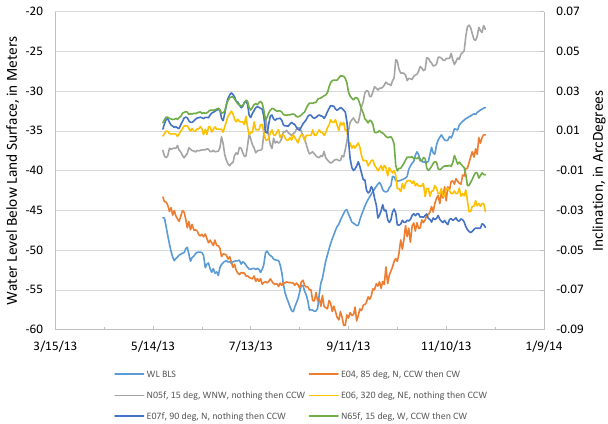
Figure 4. Biaxial tilt compared with water-level fluctuation in ob- servation well 0.8km to the south. Sensor locations are in Fig. 1. The legend gives the azimuth of the vertical plane of tilt, viewing di- rection, and sense of rotation for two segments of each graph. CW is clockwise; CCW is counterclockwise. Response to water-level fluc- tuation is delayed about one month and sensors on opposite sides of the fissure zone respond with the opposite sense. Only E04 and E07f exhibited tilt in the vertical plane orthogonal to the